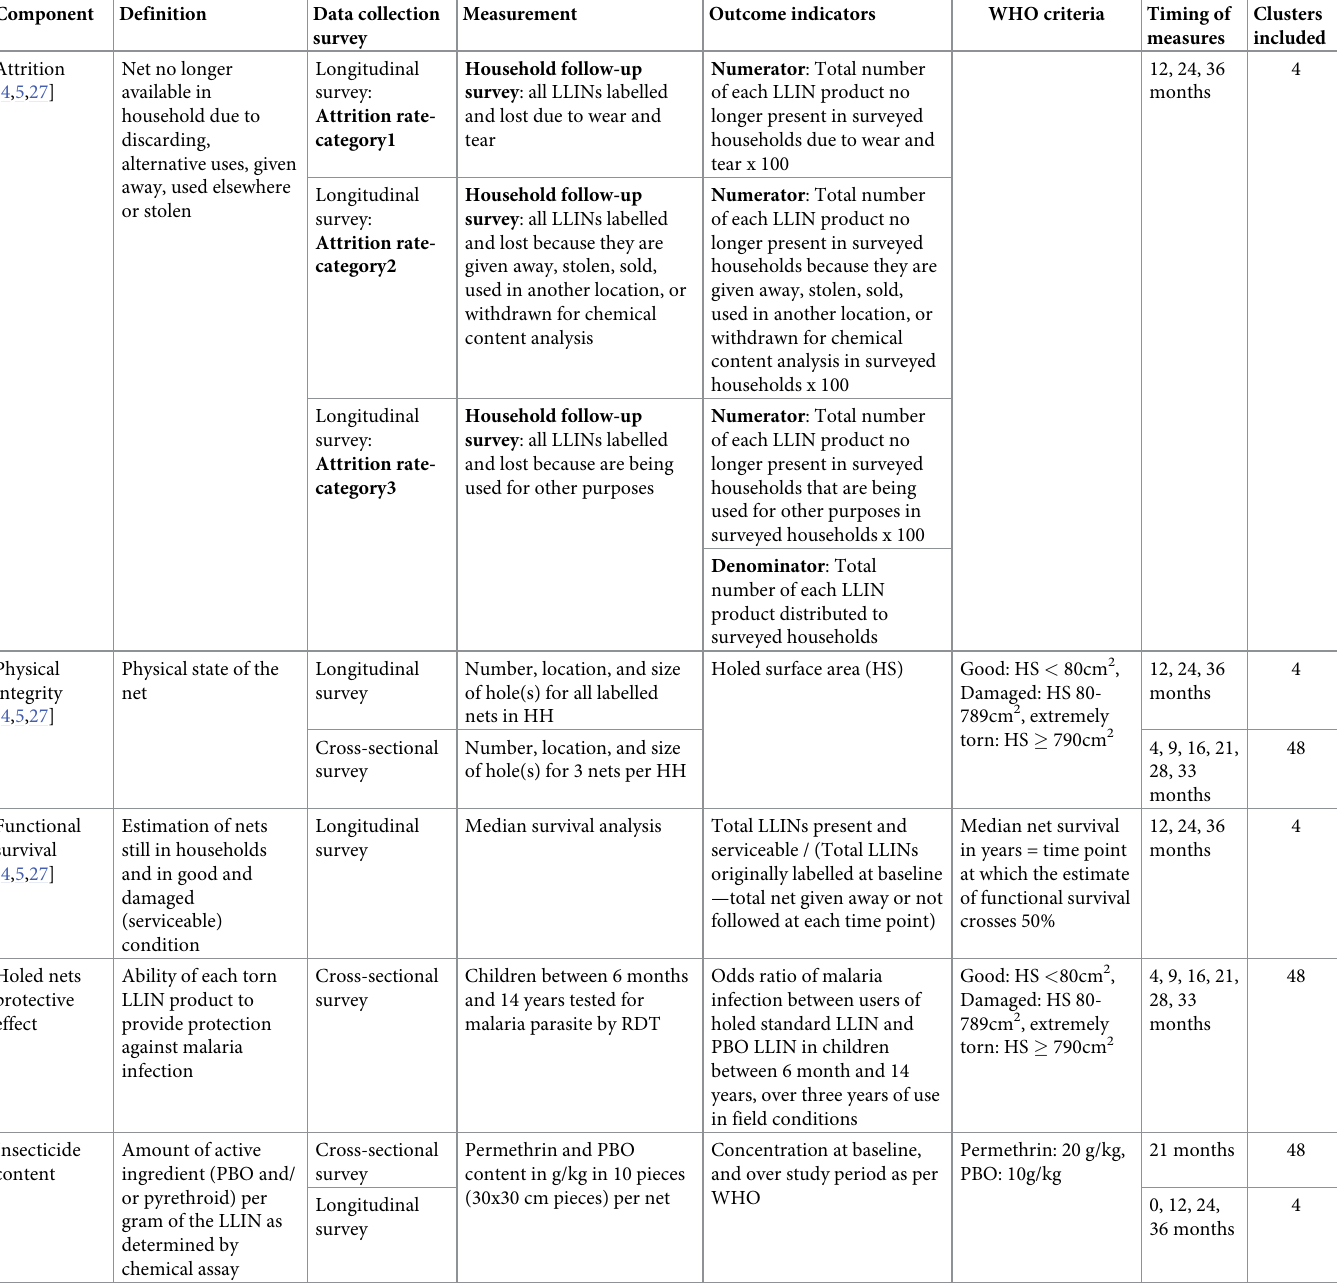
Table 1. Measurement, frequency, and outcomes of durability